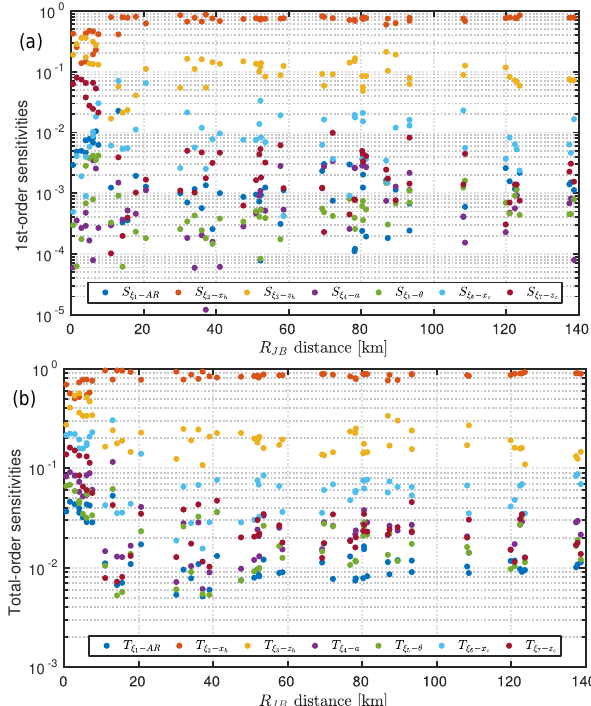
Figure 7. First- (a) and total-order (b) sensitivity indices at each